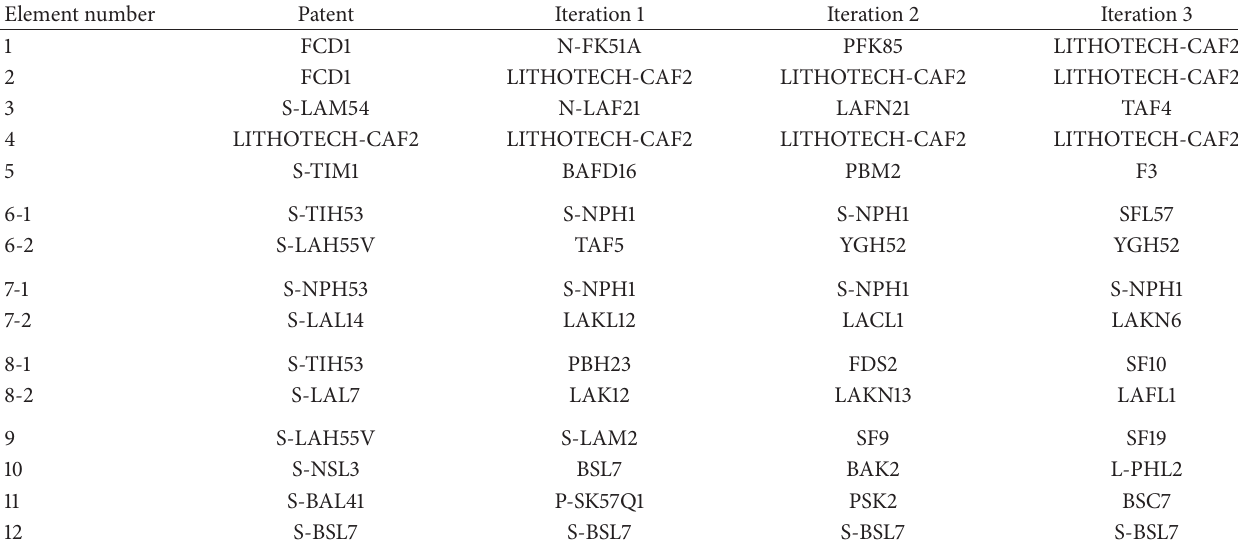
Table 1: Optical glasses used in designs in Figures 6 and 7.